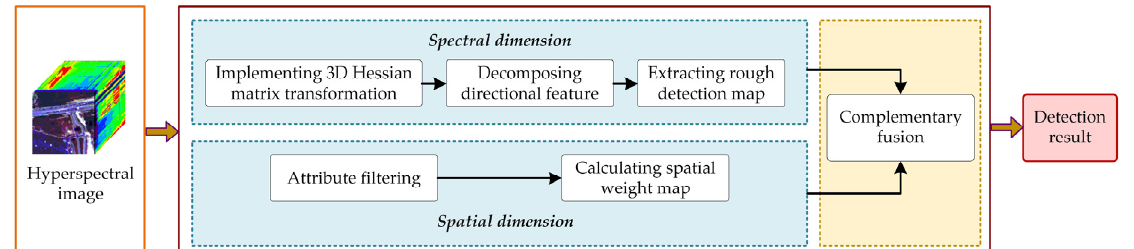
Figure 1. Schematic of the proposed spectral–spatial complementary decision fusion for hyperspectral anomaly detection.